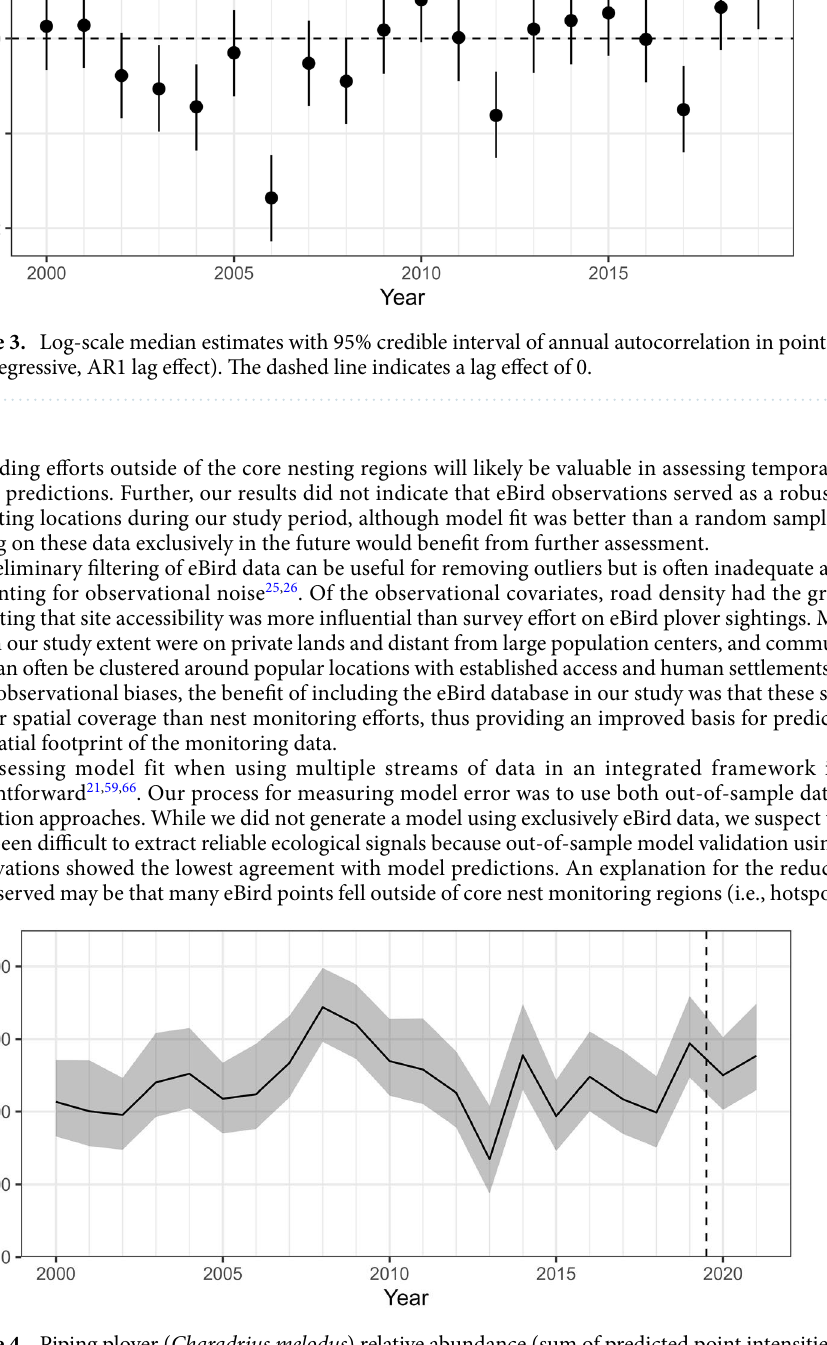
Figure 4. Piping plover ( Charadrius melodus ) relative abundance (sum of predicted point intensities) across the U.S. Prairie Pothole Region in each year. Estimates were calculated using pixels that were greater than the habitat suitability threshold. Estimates from 2020 and 2021 were based on an average spatial random field and habitat associations generated from nesting data collected between 2000 and 2019 (denoted by the dashed vertical line). The shaded area indicates 95% confidence